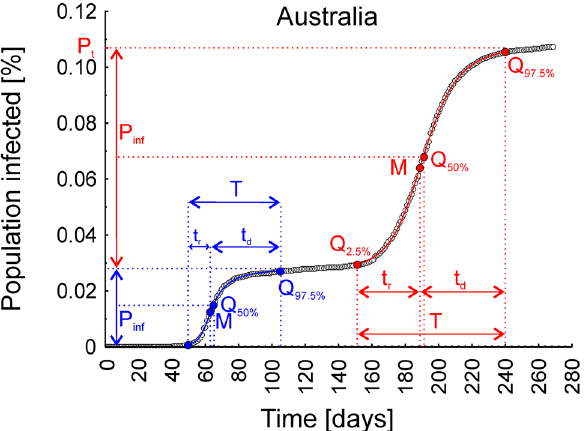
Figure 1. Graphical presentation of the interpretation of the parameters obtained from the Johnson cumulative density function fitted to the cumulative epidemic curve, describing the dynamics of the two infection waves observed in Australia. P inf —the total percentage of infections in a given infection wave, Q 2.5% —the day the infection wave started, Q 97.5% —the day the infection wave ended, Q 50% —the day that half of the total percentage of infections during a given wave was reached, M —the day the infection wave peaked, T —the duration of the wave, t i —the duration of the wave increase, t d —the duration of the wave decrease, and P t —the total percentage of the population infected after two infection